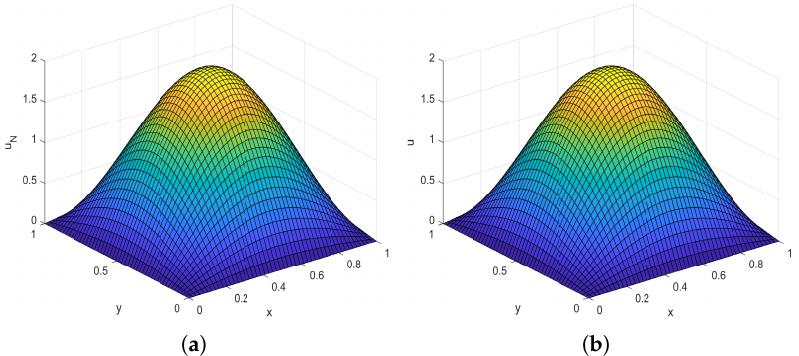
Figure 2. Numerical solution and exact solution for Case 2 at the final time t = 1 with α = 0.7, β = 0.8, θ = 0.2, τ = 1/320, h 1 = h 2 = 1/50. ( a ) Numerical solution. ( b ) Exact solution.